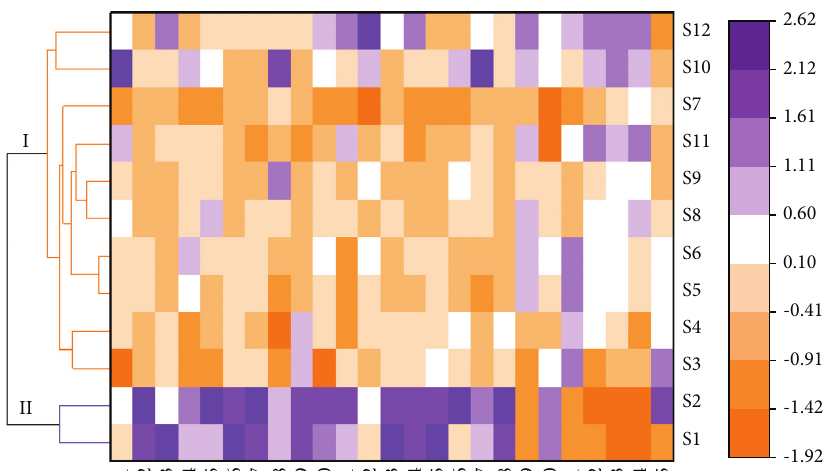
Figure 4: Hierarchical clustering analysis (HCA) with heatmaps based on the common peak areas for 12 batches of TMOL